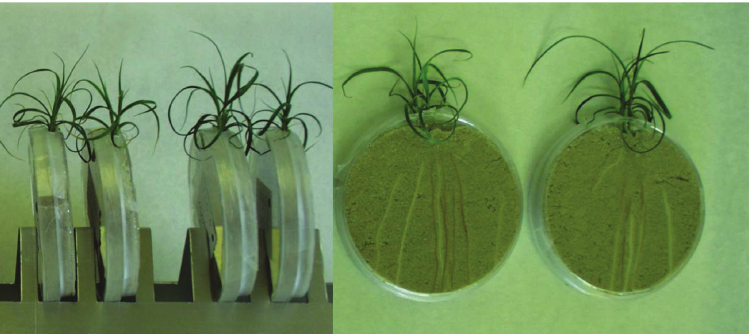
Fig 1. Pictures of the experimental set-up of sand microcosms with Carex arenaria (sand sedge) plants.